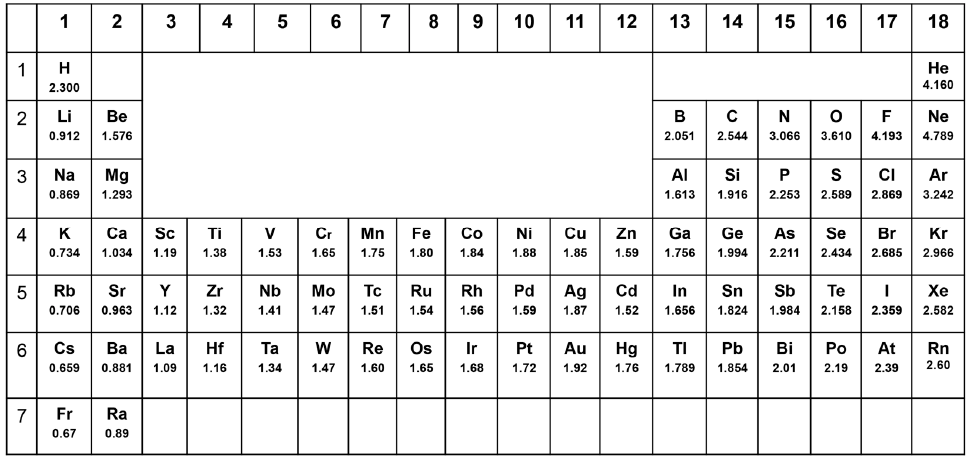
Table 2. Allen’s electronegativities of elements in the Periodic Table.